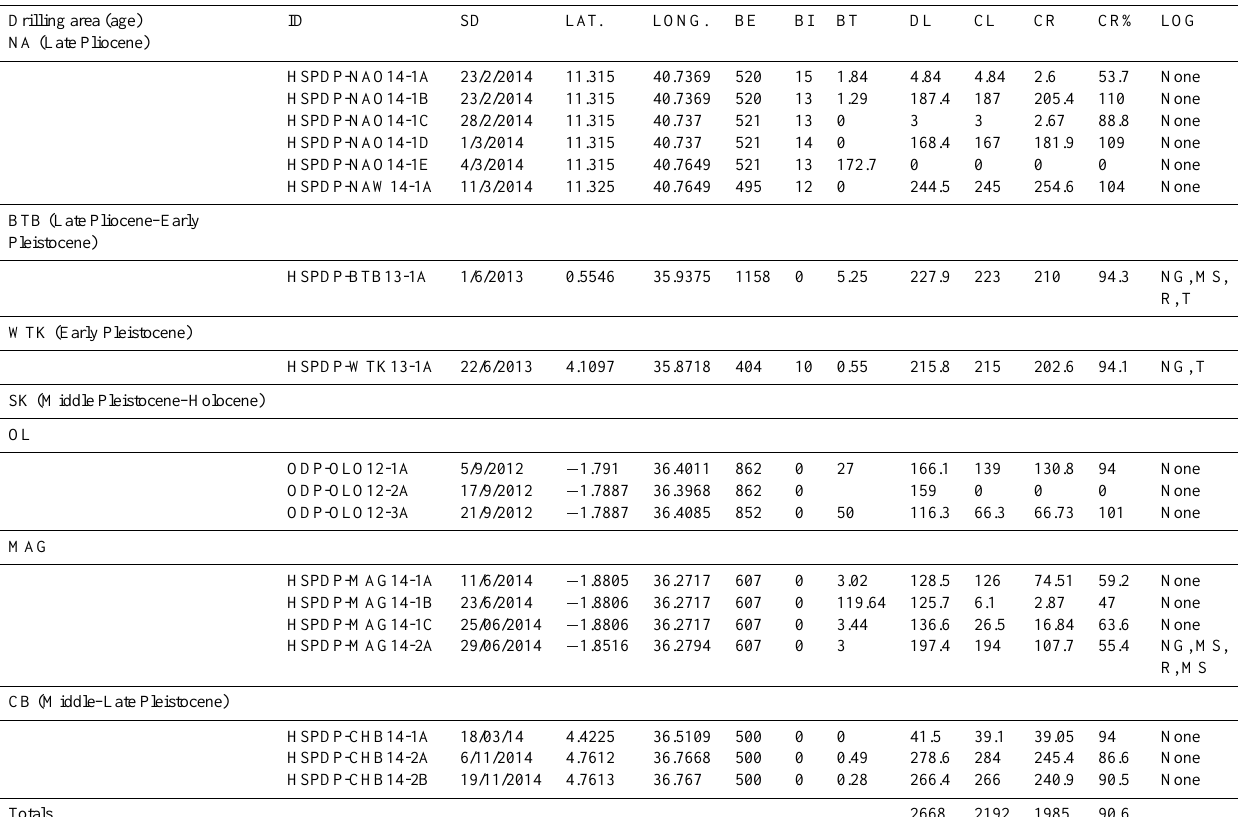
Table 1. Borehole site information for the HSPDP. DA: drilling area; age: approximate age range of borehole sediments; NA: Northern Awash, Ethiopia; BTB: Baringo/Tugen Hills, Kenya; WTK: West Turkana, Kenya; SK: southern Kenya; KO: Koora Plain/Olorgesailie; MAG: Lake Magadi; CHB: Chew Bahir, Ethiopia; ID: borehole identification number; SD: spud date; LAT: latitude N ( − : S); LONG.: longitude E; BE: borehole surface elevation in meters above sea level; BI: borehole inclination in degrees off vertical; BT: borehole top depth in meters to top of cored interval from surface; DL: drilled length in meters; CL: cored length in meters; CR: total core recovered in meters; CR: percentage core recovery; LOG: downhole logging type; NG: natural gamma (U, Th, K); MS: magnetic susceptibility; R: resistivity;